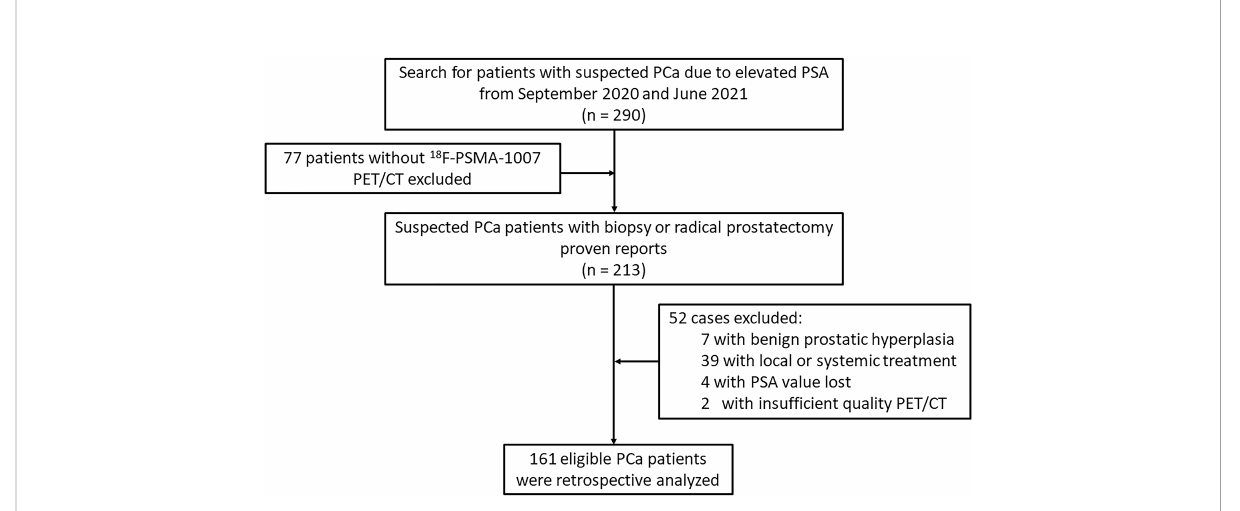
FIGURE 1 Flowchart of the prostate cancer patient ’ s